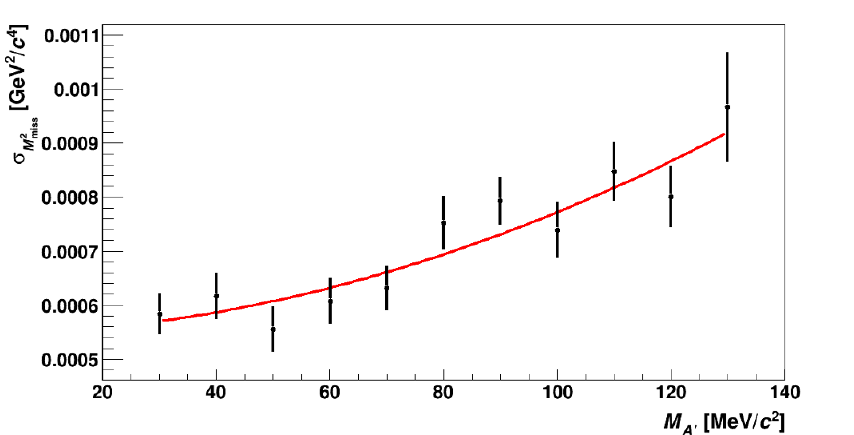
Figure 4 . Resolution on the squared missing mass for events satisfying the signal selection criteria, from the simulation of the decay chain K + ! (cid:25) + (cid:25) 0 followed by (cid:25) 0 ! A 0 (cid:13) , as a function of M A 0 . A polynomial function describing the mass dependence is also